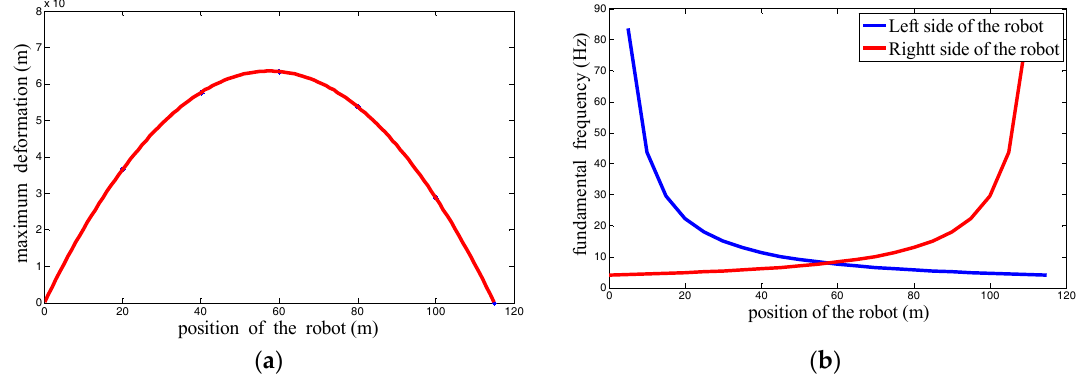
Figure 12. Simulation results: cable deformation and frequency. ( a ) The relationship between the position of the robot and the maximum deformation; ( b ) The change in fundamental frequency of the cable.